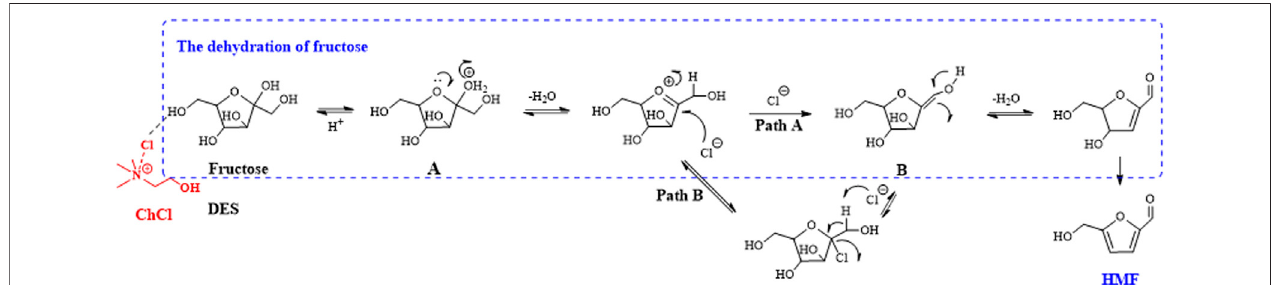
FIGURE 4 | Possible synthesis mechanism of HMF from fructose in the deep eutectic solvents (DES)/acetonitrile biphasic system.